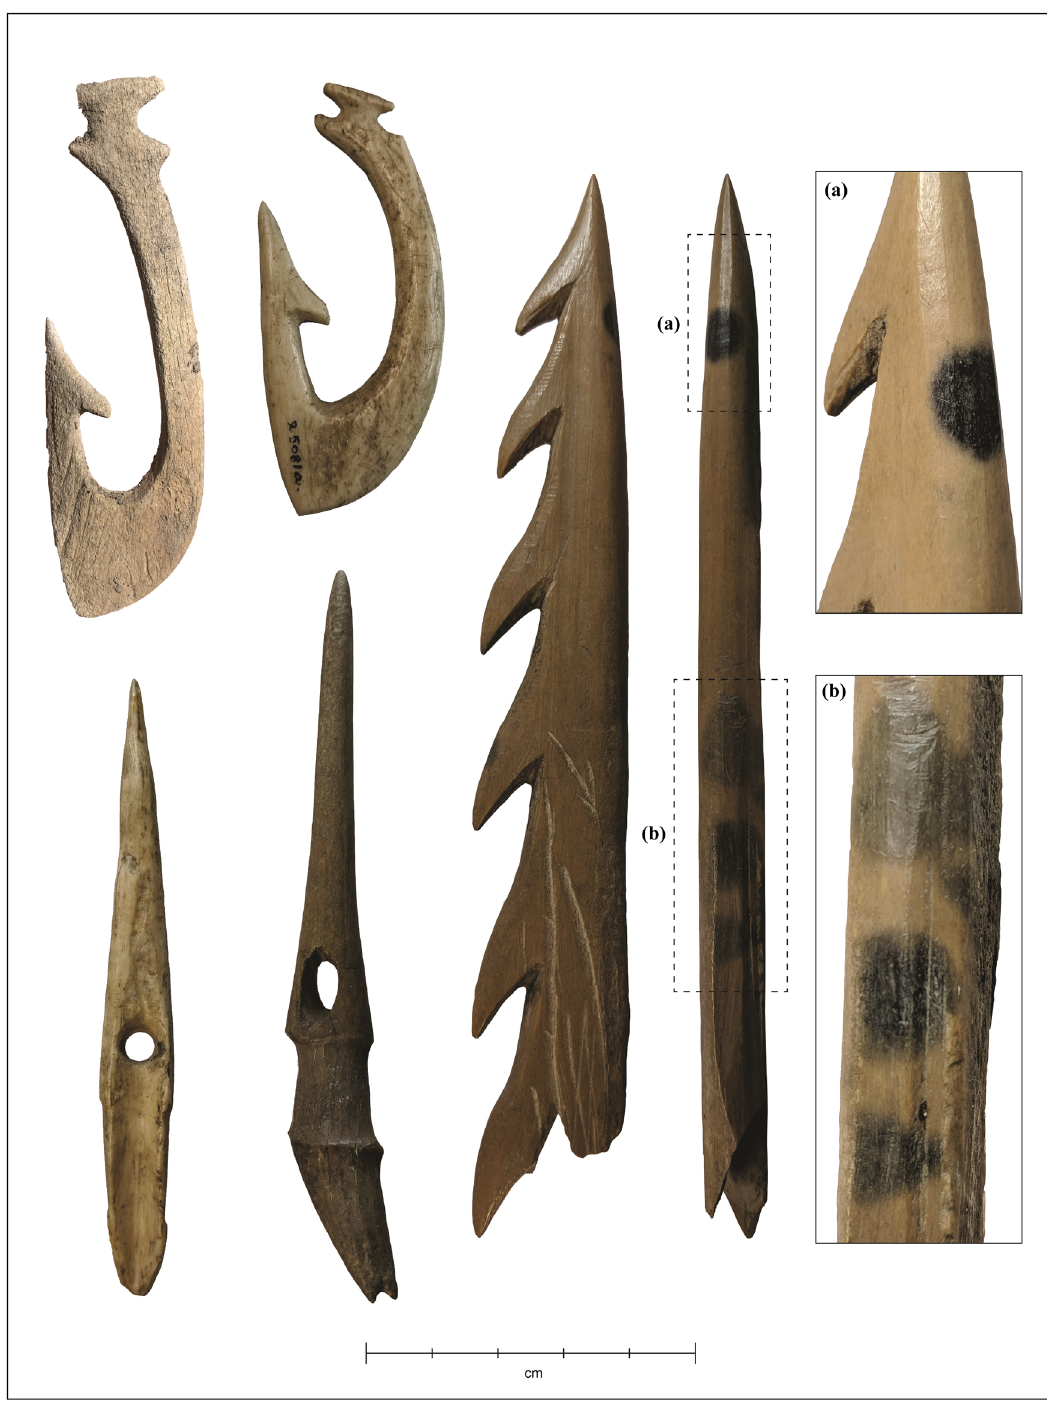
Figure 2: Osseous tools from the Jortveit site. Upper right: Two fi shhooks; the left hook was discovered in 2020, the right hook in 1930 ’ s. The hooks demonstrate the constant degradation of preservation conditions at Jortveit due to drainage and other earthwork. Down left: Two toggling harpoons. The toggling harpoon to the right was radiocarbon dated to 3631 – 3372 cal BCE ( see details in the text ) . Right: Barbed harpoon with burn marks ( a and b ) . This barbed harpoon has been dated to 2878 – 2353 cal BCE. The burn marks supports the interpretation that night fi shing could had taken place within the bay at Jortveit. Photo: Svein Vatsvåg